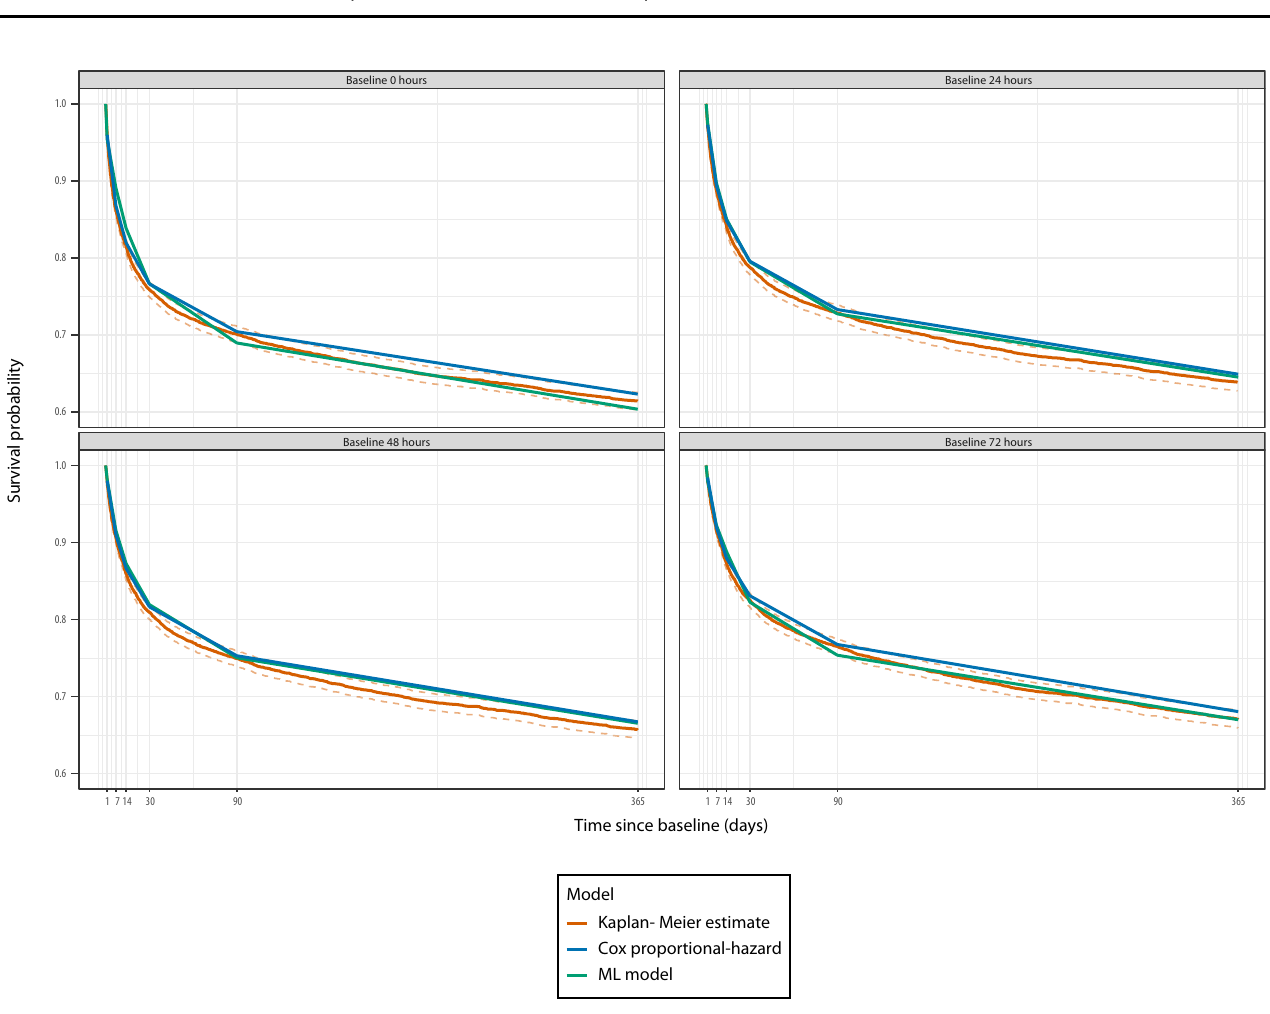
Fig. 2 Comparison of survival predictions by our deep learning model and a Cox proportional-hazard model. The broken lines around the KM curves represents 95% con fi dence intervals. Each baseline (0, 24, 48, and 72 h) has its own curve, in a separate panel. The predictions for both models are close to the Kaplan-Meier estimate for the full hold-out test